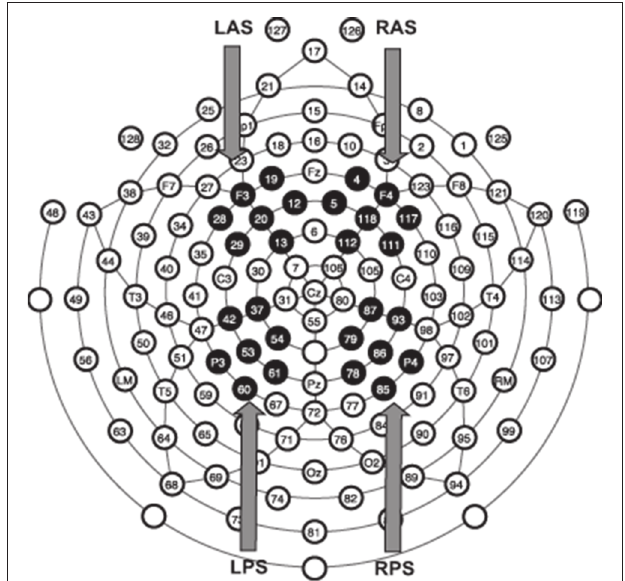
FIGURE 2 | Regions of interest (ROIs) for event-related potentials (ERPs) analysis. Electrode montage representing the location of all 128 electrodes. Black filled electrodes represent the four different groups of seven electrodes averaged together to form the four ROIs for ERP analysis. LAS, left anterior superior; RAS, right anterior superior; LPS, left posterior superior; RPS, right posterior